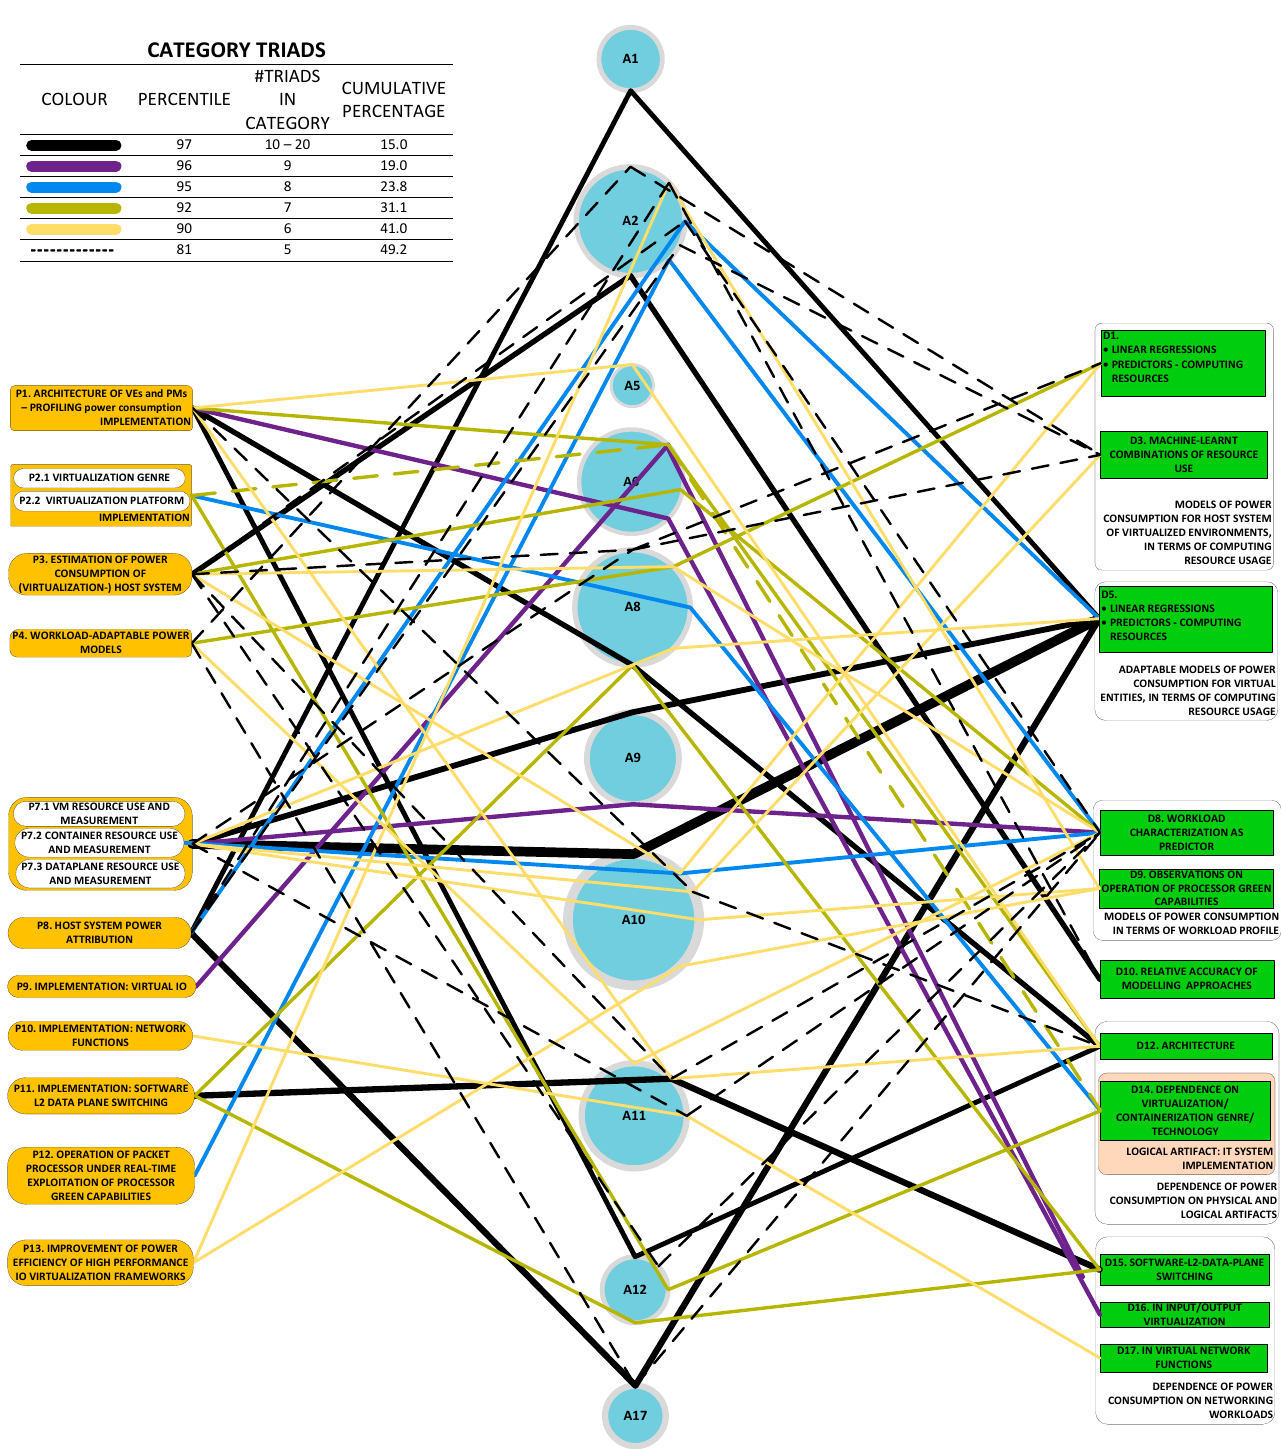
Figure 19. Triads. D1 [57–59,69,75]; D3 [62,77,79]; D5 [58,59,69,72,75,81,82,84,86]; D8